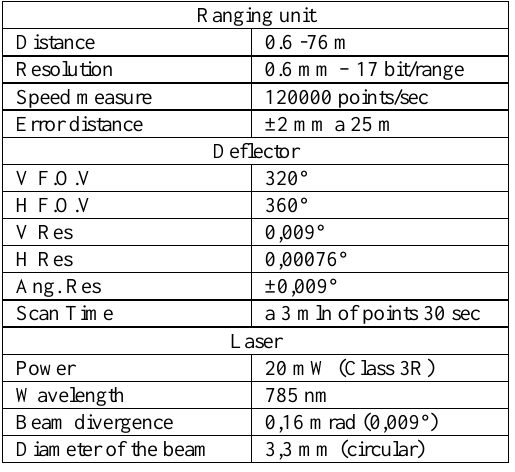
Table 1. Characteristics of the laser scanner used for the survey